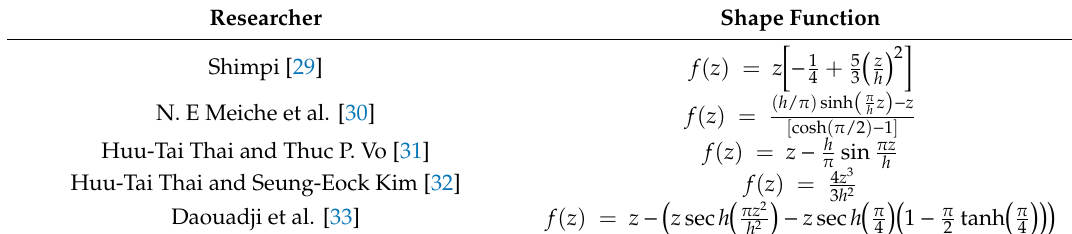
Table 1. Shape functions of several four-variable refined plate